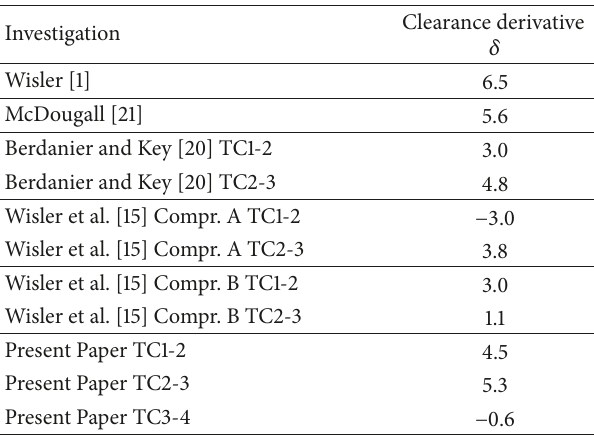
Figure 5: Stalling flow coefficient at different tip clearance sizes. Table 3: Clearance derivatives of different